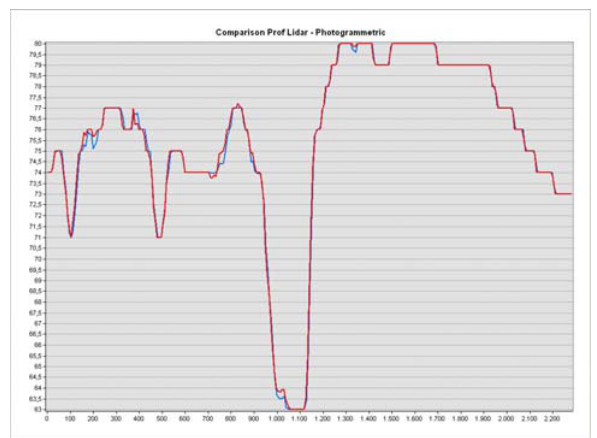
Figure 13. Comparison between profiles (test 2)